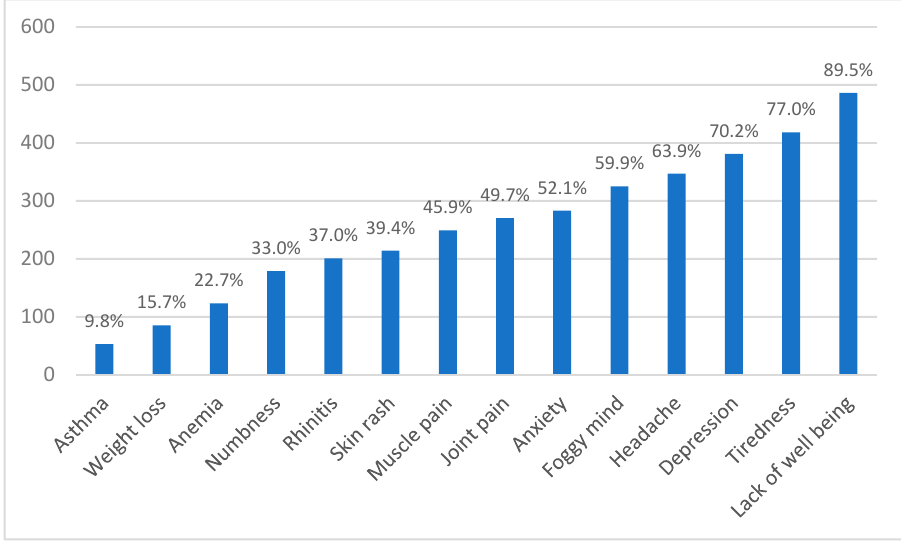
Figure 3. Extraintestinal manifestations in Brazilian with suspicion of non-celiac gluten sensitivity (N =